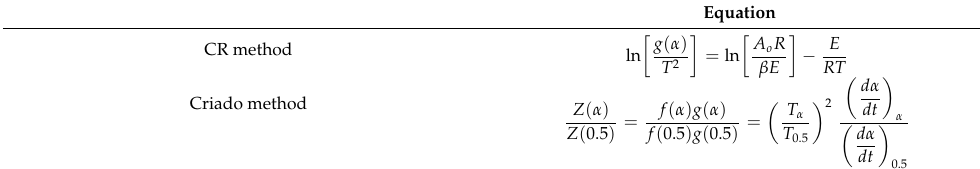
Table 3. Equations for two model-fitting methods.